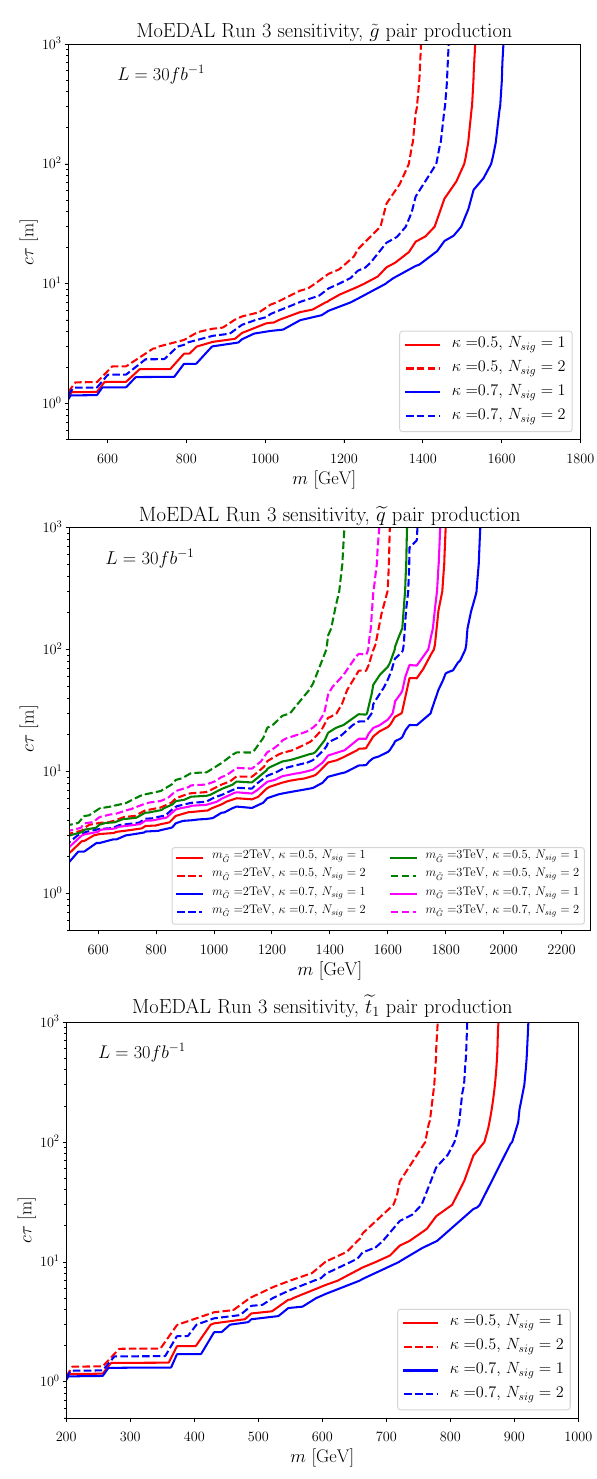
Fig. 2 The expected sensitivities of MoEDAL for various long-lived strongly-interacting sparticle species, assuming 30 fb − 1 of integrated luminosity. Top panel: the gluino, middle panel: squarks, bottom panel: the stop